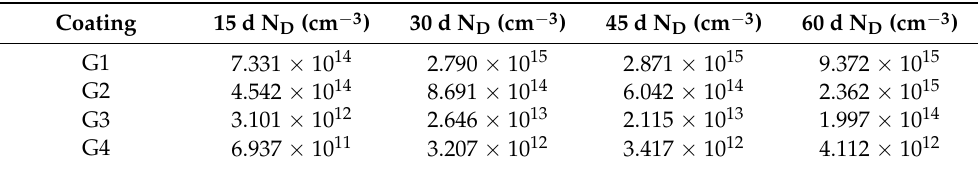
Table 4. Each coating’s carrier density for 15 d, 30 d, 45 d, 60 d in 40% Seawater.